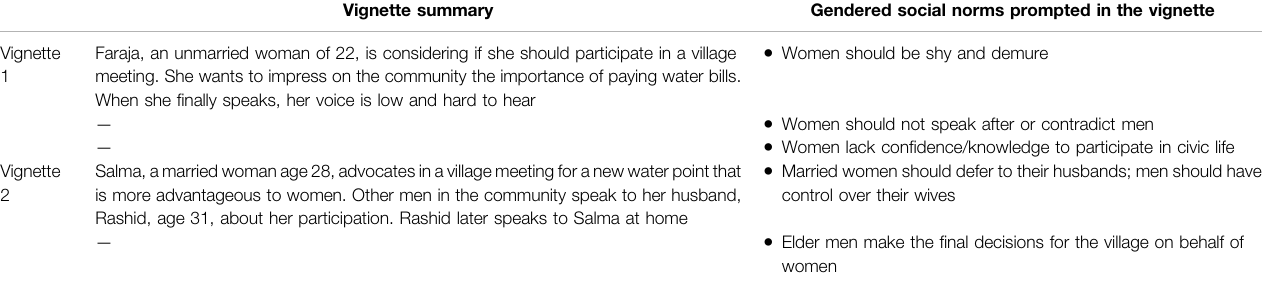
TABLE 2 | Social norm